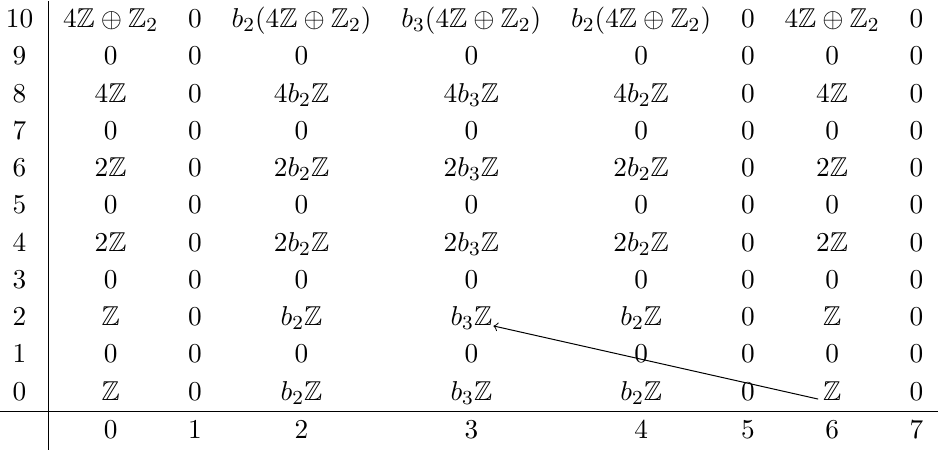
( CY ) . One of the 3 n is displayed (for q = 0 ). They eventually → E 3 6 ,q 3 ,q +2